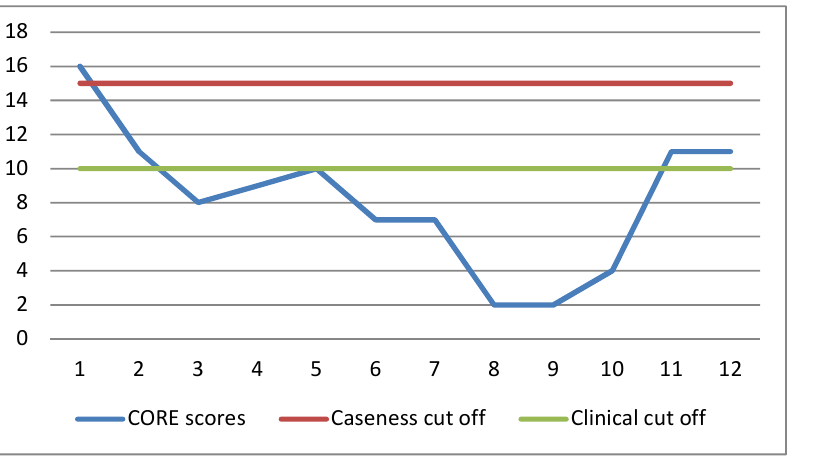
Figure 2: Weekly and Follow-Up mean PQ scores (clinical significance 3)